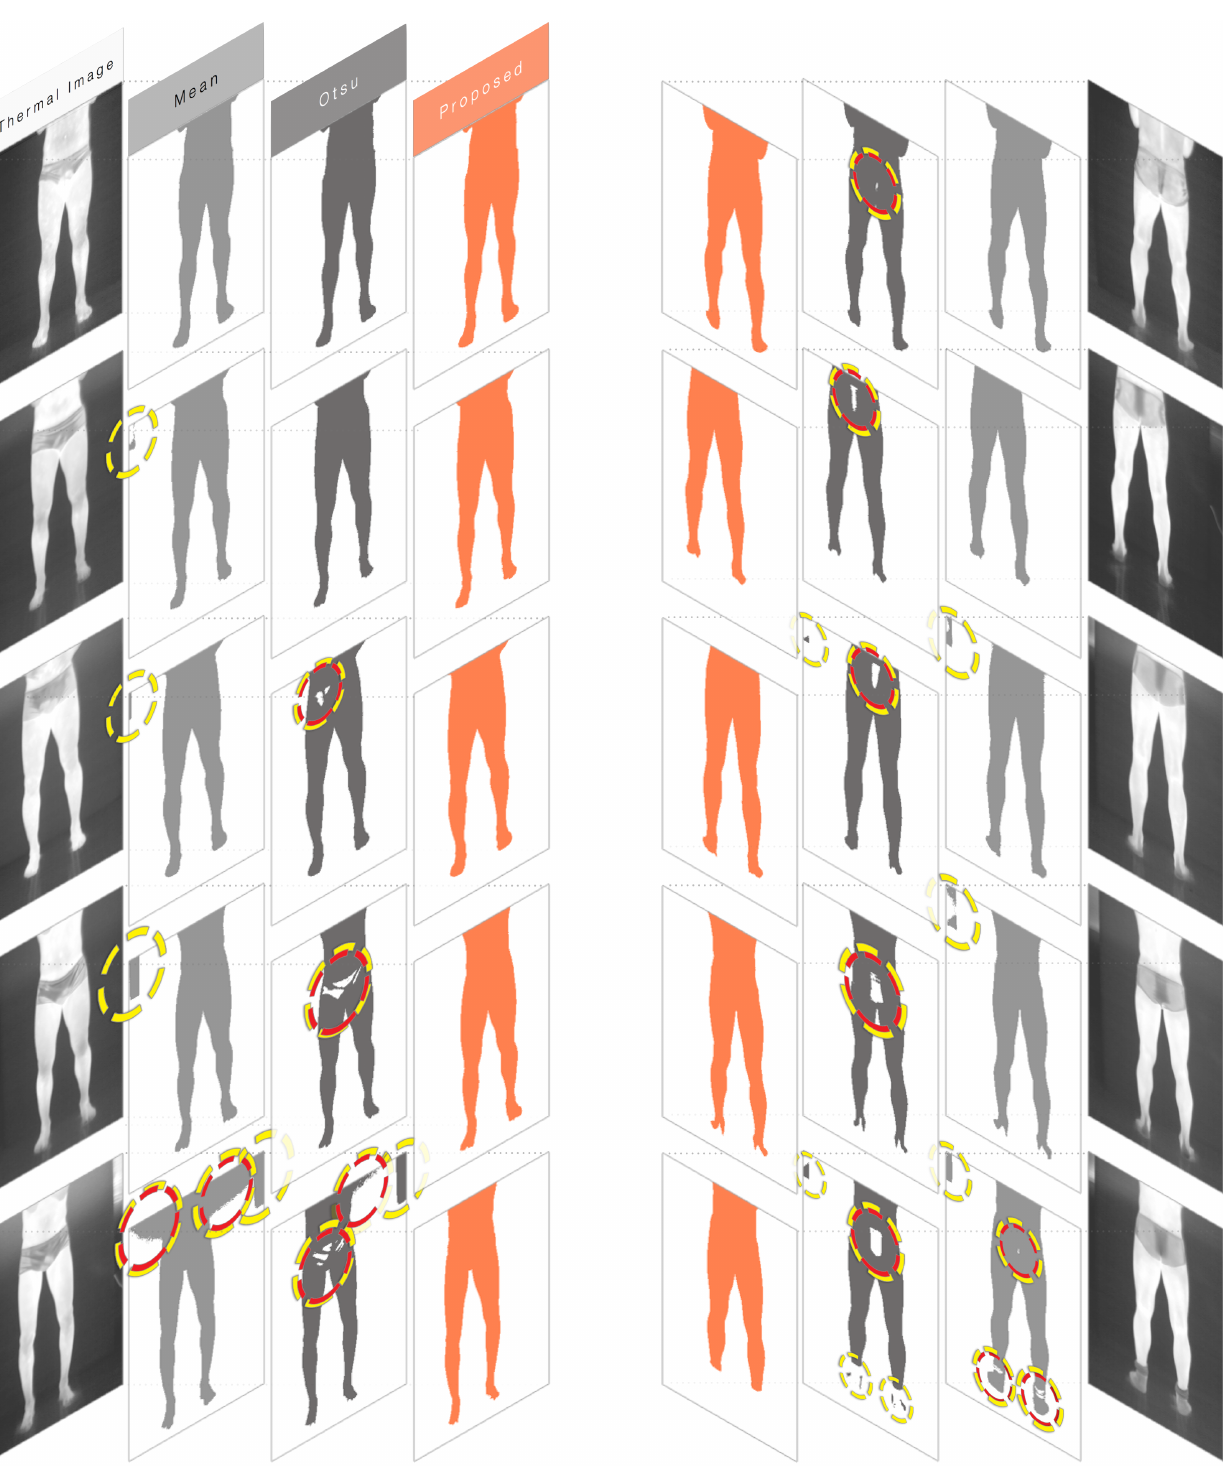
Figure 7. Experiment on the automatic selection of regions of interest. Ten thermograms from different players were selected at random. Three masks were automatically extracted using the mean method (in light gray), Otsu’s method (in dark gray), and the segmentation method proposed by the authors (highlighted in orange). Issues in the masks are indicated in dashed yellow circles. Problems with the main ROI are highlighted with dashed red